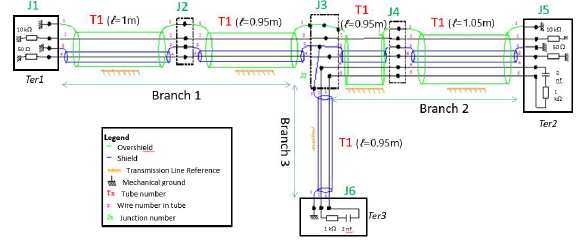
FIGURE 2: Wiring topology under